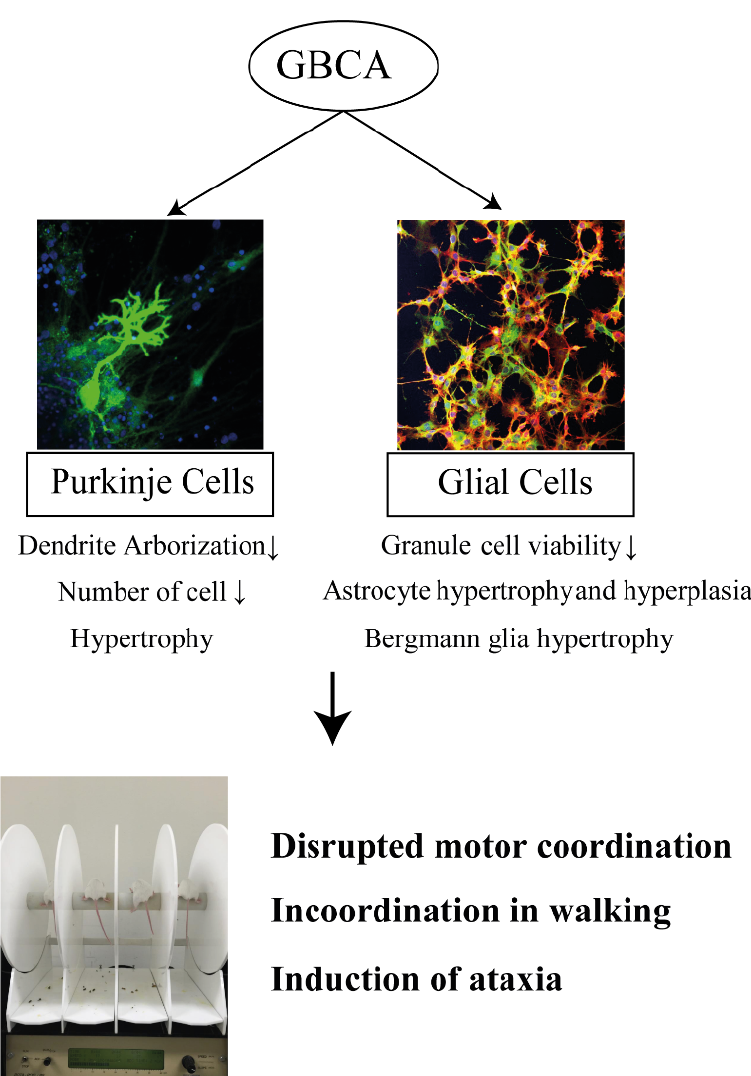
Figure 2. Possible mechanism of GBCA toxicity in the cerebellum.